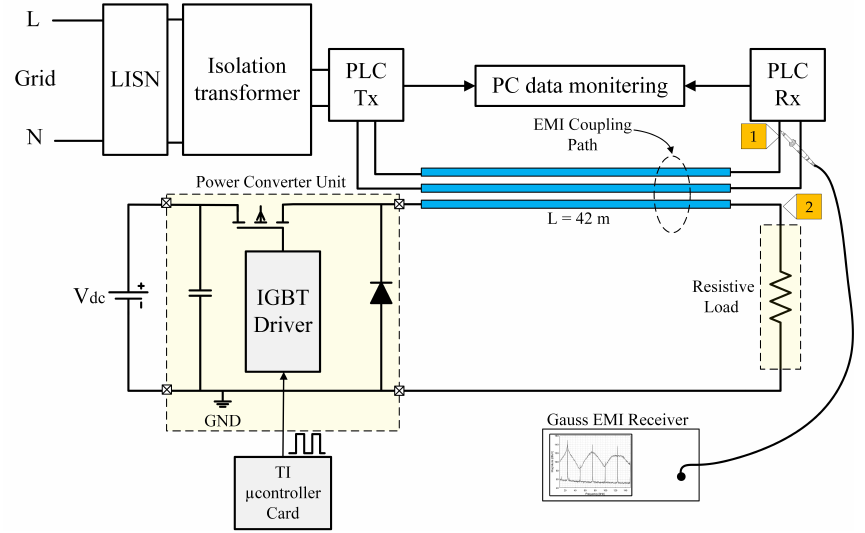
Figure 3. Connection diagram of the proposed experimental